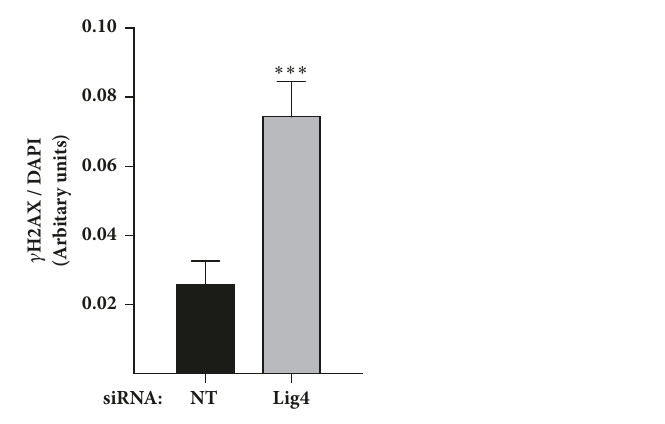
Figure 6: Lig 4 d epletion alone increase d persistence of DNA d o ub le stran d b rea k s. BT549 cells were transfected with siRNA targeting Lig4 or scrambled control (NT) followed by immunostaining for 𝛾 H2AX foci. 𝛾 H2AX foci were quantified using ImageJ software with DAPI stained area defined as region of interest per image and scored. Mean intensity signal of 𝛾 H2AX was normalized to the DAPI stained area per image ( ∗ ∗ ∗ p < 0.001).